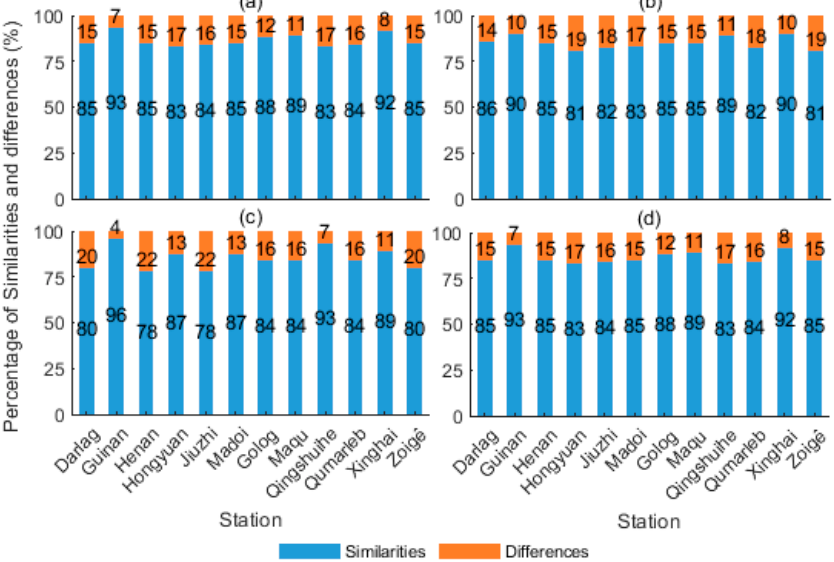
Figure 2. Differences and similarities (%) of drought classes on ( a ) monthly, ( b ) seasonal and ( c ) vegetation growing seasonal (VGS) and ( d ) annual scale according to SPI and RDI values.